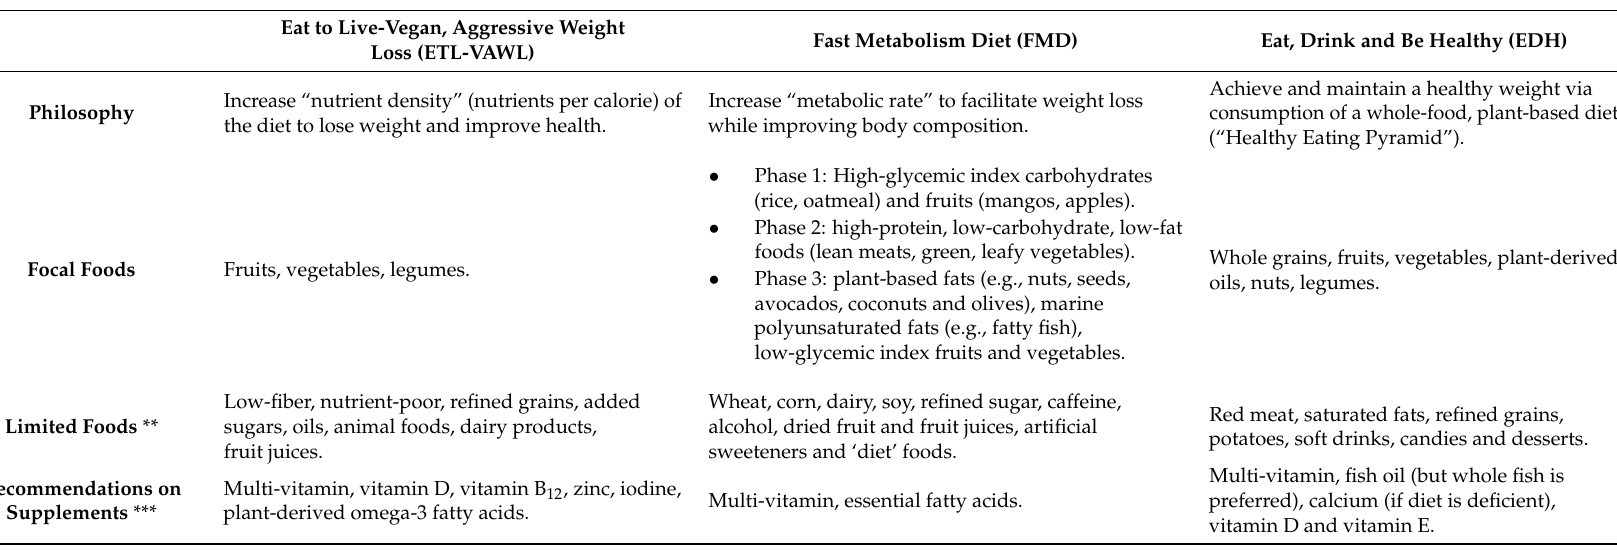
Table 1. Summary of three weight-loss diet plans for meal-plan analysis